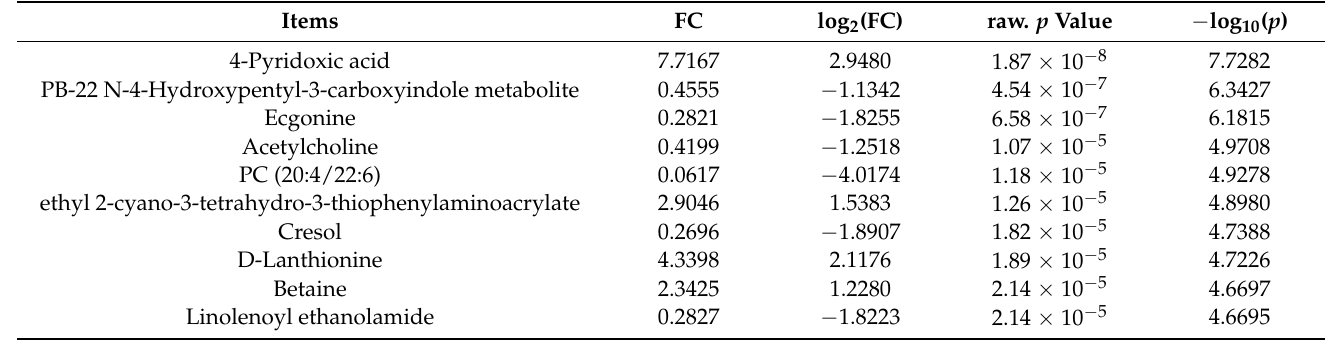
Table 4. Top 10 differential yolk metabolites identified between male and female chicken embryos at E15 ( n = 3).